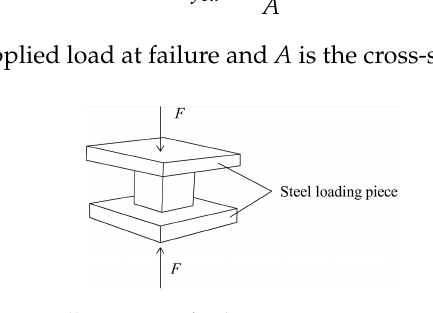
Figure 5. Illustration of cubic compressive strength test.